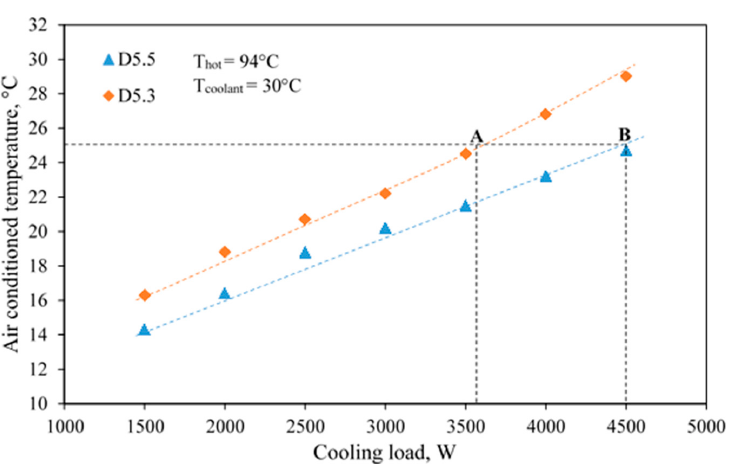
Figure 6. Variations of the T air-cond with the cooling load .